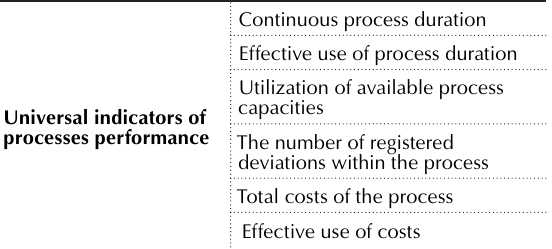
Table 2. Universal indicators of measuring processes performance